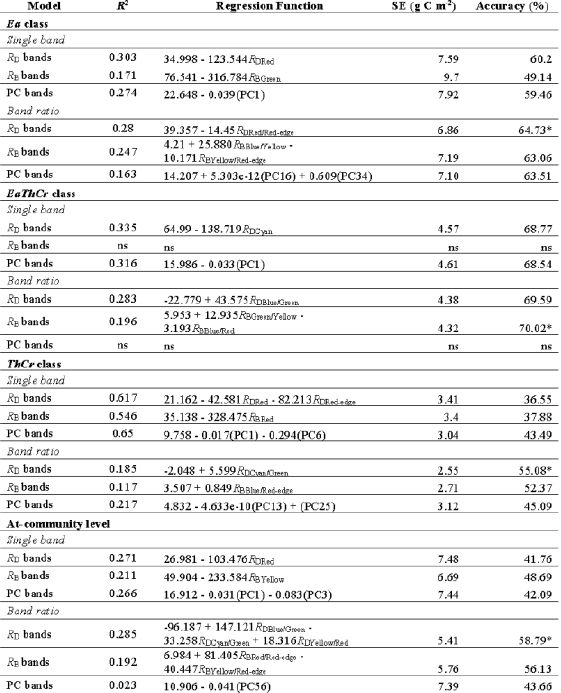
Table 3. Accuracy assessment results of the seagrass species